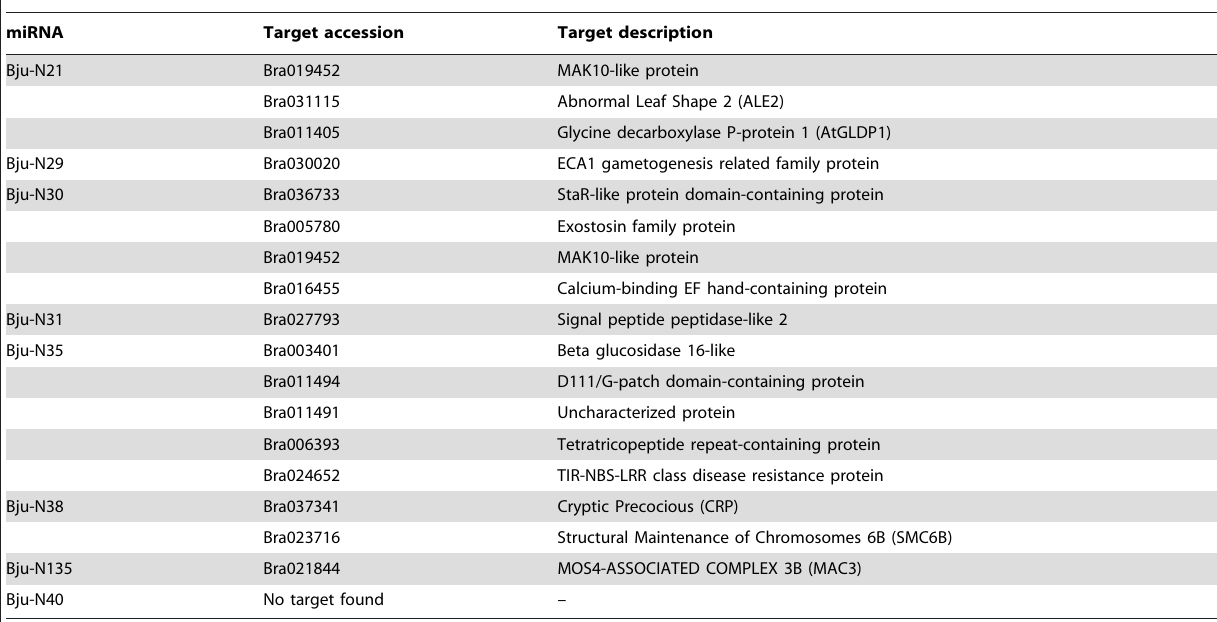
Table 4. Putative targets of selected novel miRNAs.